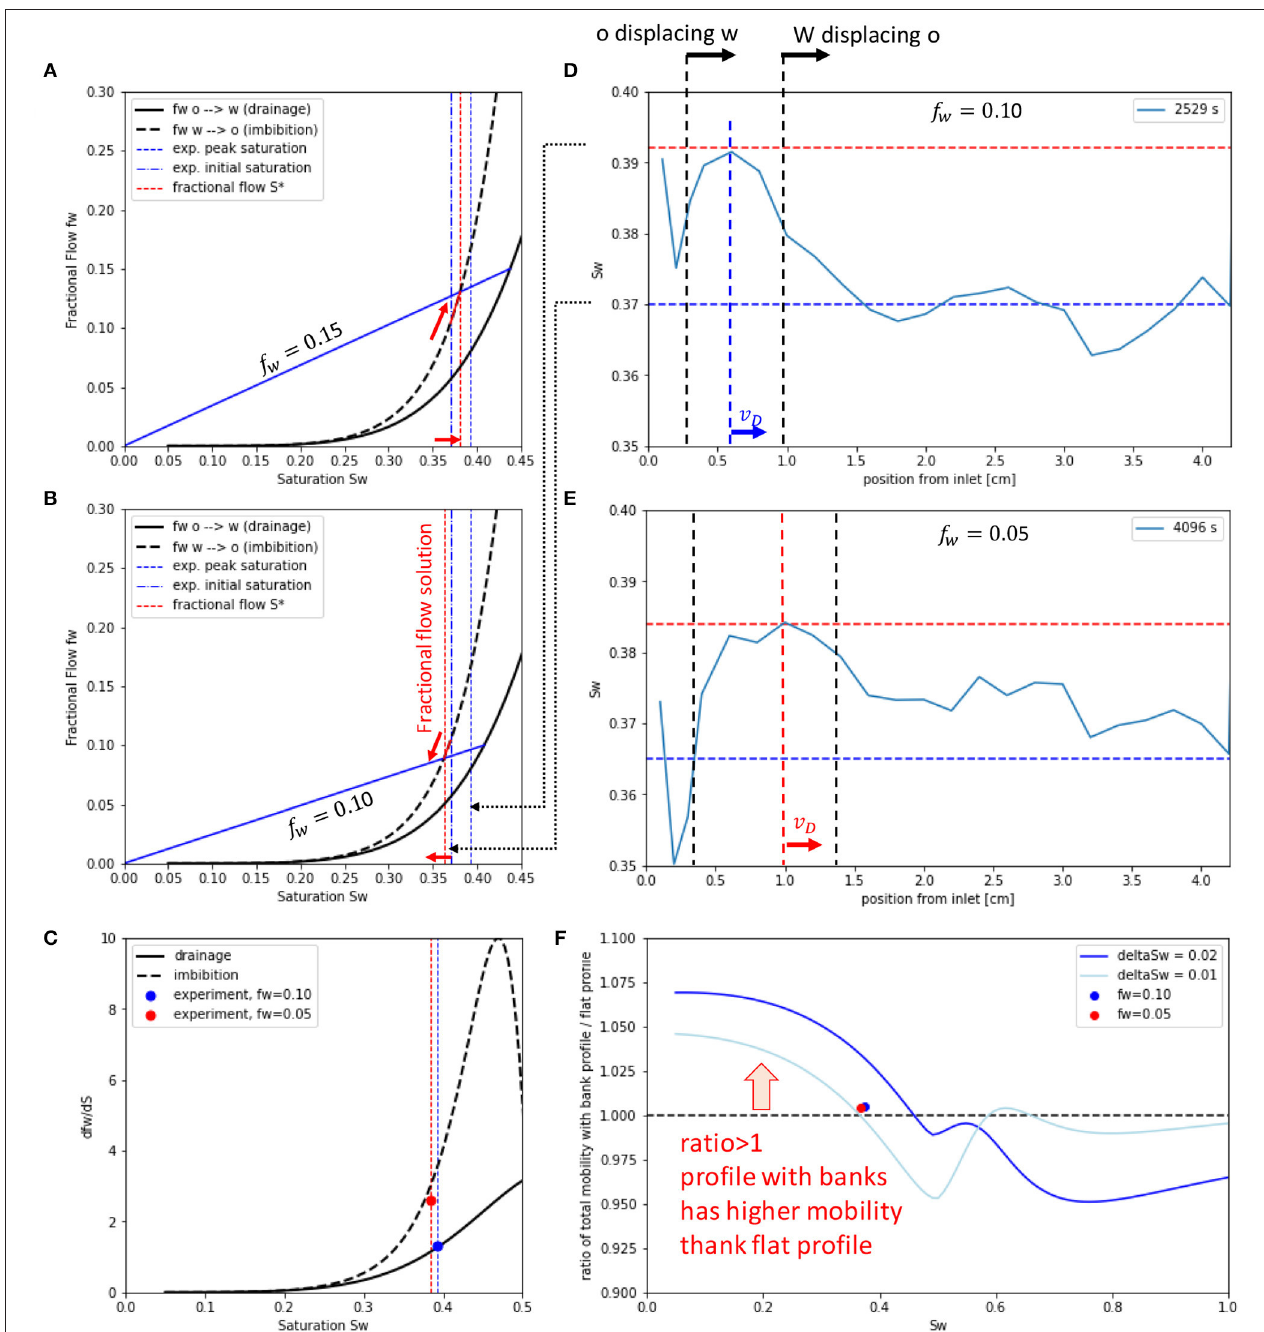
FIGURE 8 | Fractional flow f w ( S w ) (A,B) and the derivative v D = df w / dS w (C) for f w = 0.15 (A) and f w = 0.10 (B) for the saturation interval corresponding to the top and bottom of the peak of the saturation waves (D,E) . Representative examples of the wave profile are shown for f w = 0.10 (D) and f w = 0.05 (E) . The wave for each fractional flow consists of a water peak moving from inlet to outlet, which has water displacing oil at the front and oil displacing water at the back. The respective fractional flow constructions are shown in (B) , where the flow line is constructed from the intersection of the drainage fractional flow curve at respective f w step. The fractional flow solution is the intersection between the blue line with the imbibition fractional flow curve (Lake, 1984). Note that depending on the exact value of the initial saturations (D,E) there is an inflection point 0.07 < f * w < 0.12 above which the water saturation from the fractional flow solution increases compared to the initial saturation (A) , while below f * w it decreases (B) . That would imply a change from oil pushing a water bank (drainage) at f w > f * w to water pushing an oil bank (imbibition) for f w < f * w . That could explain why the experimentally observed wave velocities follow the prediction from fractional flow theory v D = df w / dS w for drainage at higher fractional flows and the imbibition line for smaller fractional flows. That transition is within the experimental uncertainty between f w = 0.10 and f w = 0.05. A saturation profile with moving banks has an overall higher total mobility than a flat saturation profile for the saturation range S w , c < S w ≤ 0.4 − 0.5 (F) . The two experiments at f w = 0.10 and f w = 0.05 are added as points, where for the computation of mobility, respective bank saturations and lengths have been taken from (D) and (E) , respectively.